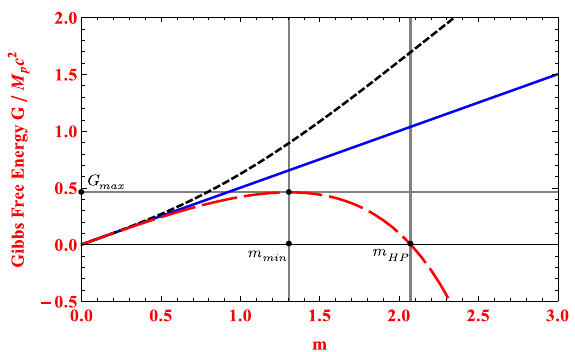
Fig. 5 The figure shows the Gibbs free energy of a Schwarzschild BH as a function of masses in the asymptotically flat case with Boltzmann ( q = 1, blue-continuous) and Tsallis entropies ( q > 1, red-dashed and q < 1,